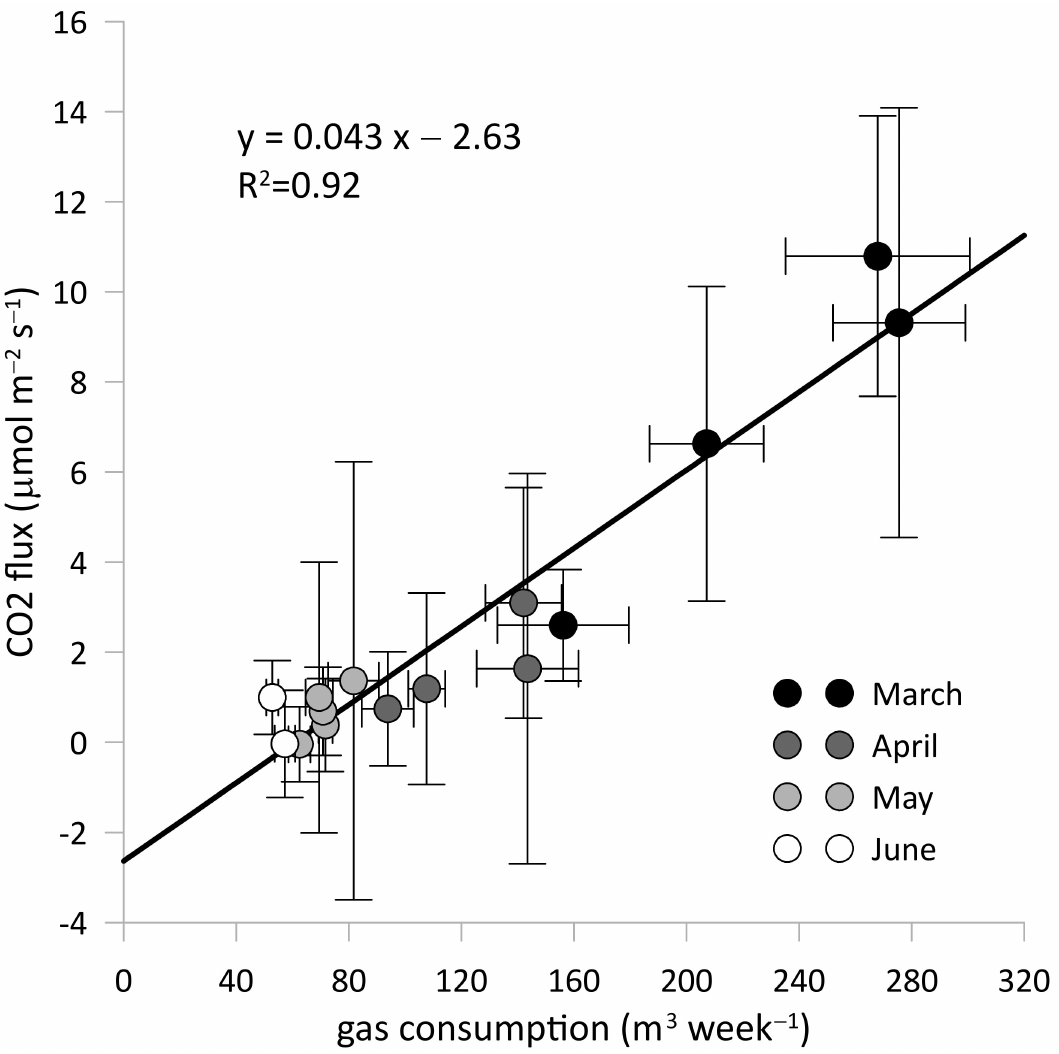
Figure 10. Relationship between weekly mean of CO 2 fluxes and gas consumption (courtesy of Amgas Srl Bari). The error bars represent the standard deviations for the gas consumption and the mean random errors for the CO 2 fluxes. Table 3. F values and P-values of the one-way ANOVA applied to mean daily CO 2 fluxes for